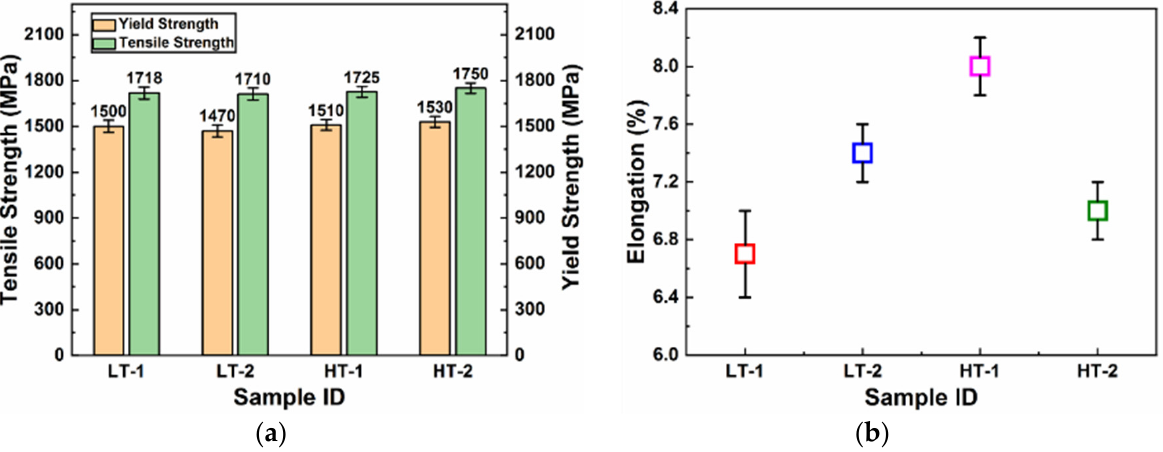
Figure 7. Tensile properties of ballistic steel samples: ( a ) yield and tensile strength; ( b ) percent elon- gation.